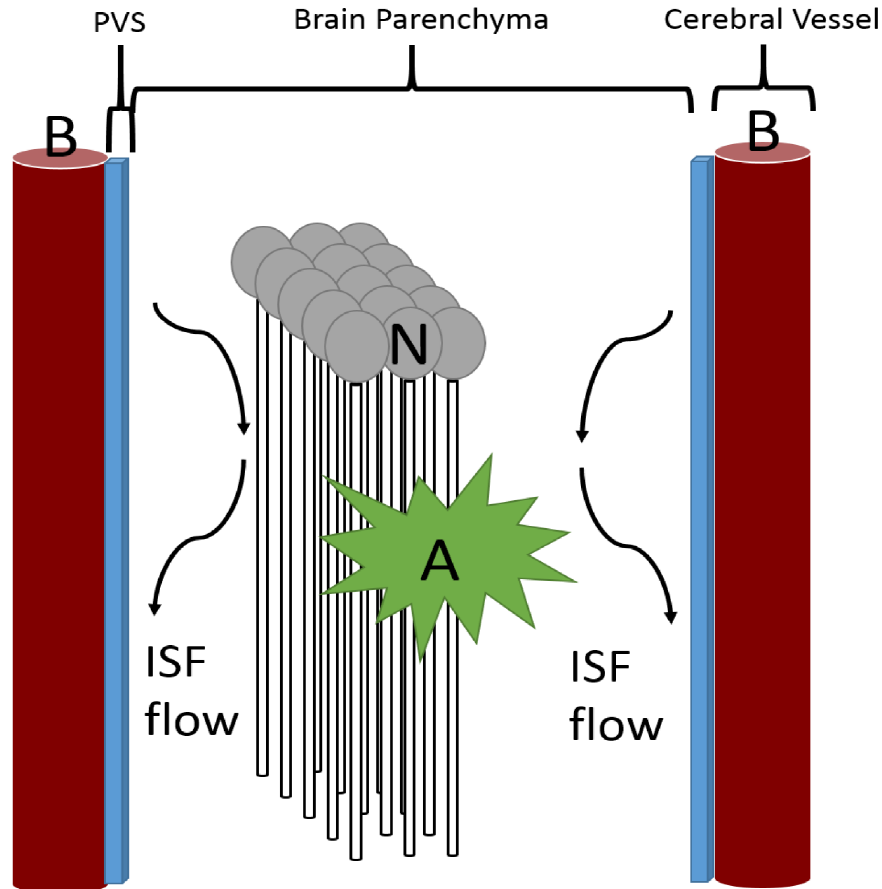
Fig 1. Three compartment model used for modeling. The brain was divided into the brain parenchyma, containing the neurons (N) and astrocytes (A); the perivascular space (PVS, blue strip) in the area between the astrocytic foot processes and the brain endothelial cells; and the cerebral blood vessels (B). Interstitial (ISF) flow is unidirectional and laminar in the regions lined by capillaries; its rate is dependent on heart rate (eg. the rate of arterial pulsations) as well as the stiffness of the vessels, which is a function of the presence of atherosclerosis, cerebral amyloid angiopathy (deposition of beta amyloid within the brain vessels) and stiffening secondary to prolonged elevations in systemic blood